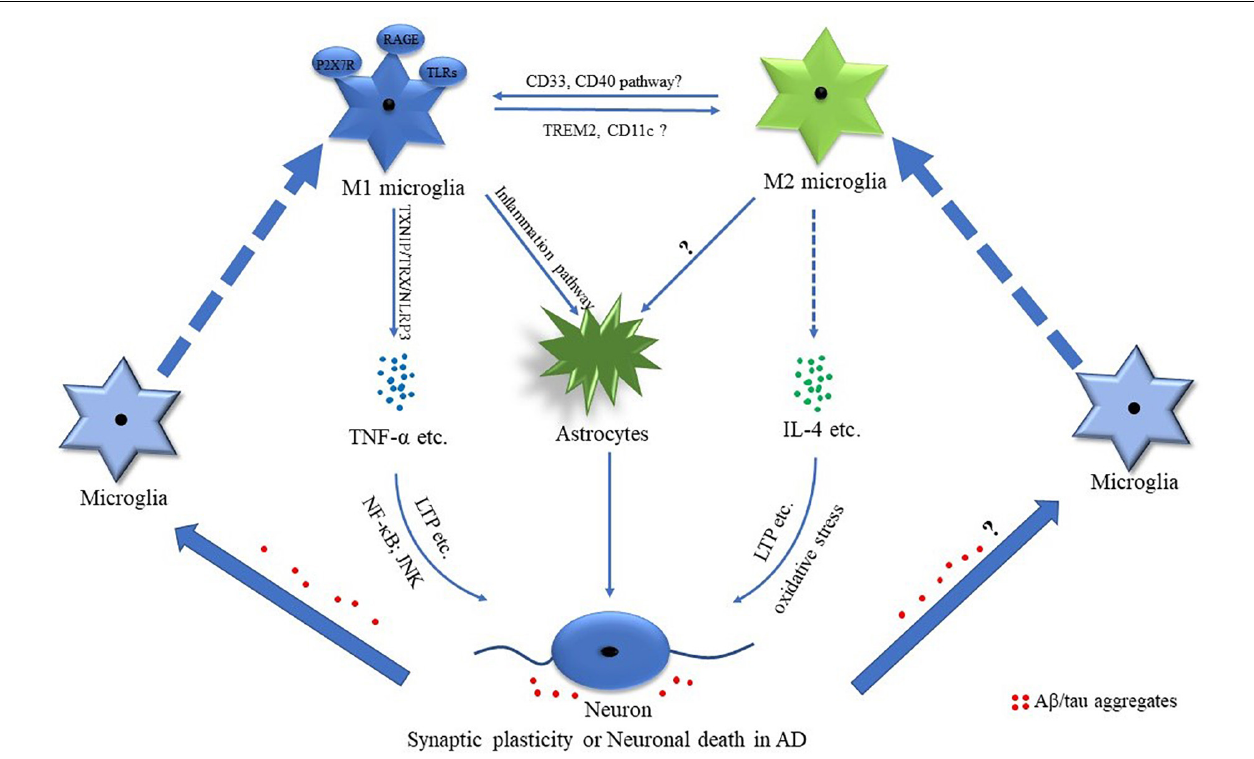
FIGURE 2 | Potential mechanisms of M1 and M2 phenotypes of microglial cells in AD. Mounting evidence suggests that M1 and M2 microglia are involved in the pathological processes of Alzheimer’s disease (AD). The AD-associated pro-inflammatory and anti-inflammatory factors such as tumor necrosis factor- α (TNF- α )